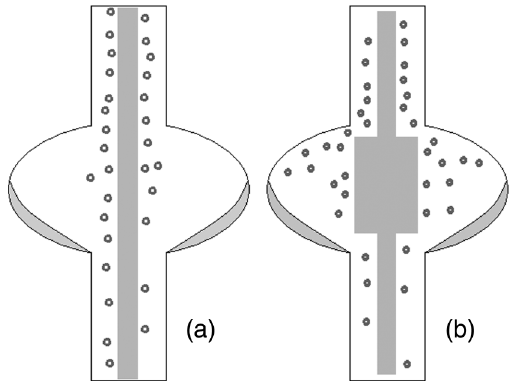
FIG. 9. Schematics of the assumed hydrogen/viscous layer distribution during VEP for two cathode shapes. The drawings are not in the correct scale. With a rod cathode (a), hydrogen runs along it, but in the case of the cathode #2, bubbles are likely to reach the surface in a viscous layer-depleted area, and this configuration generates a faster removal.